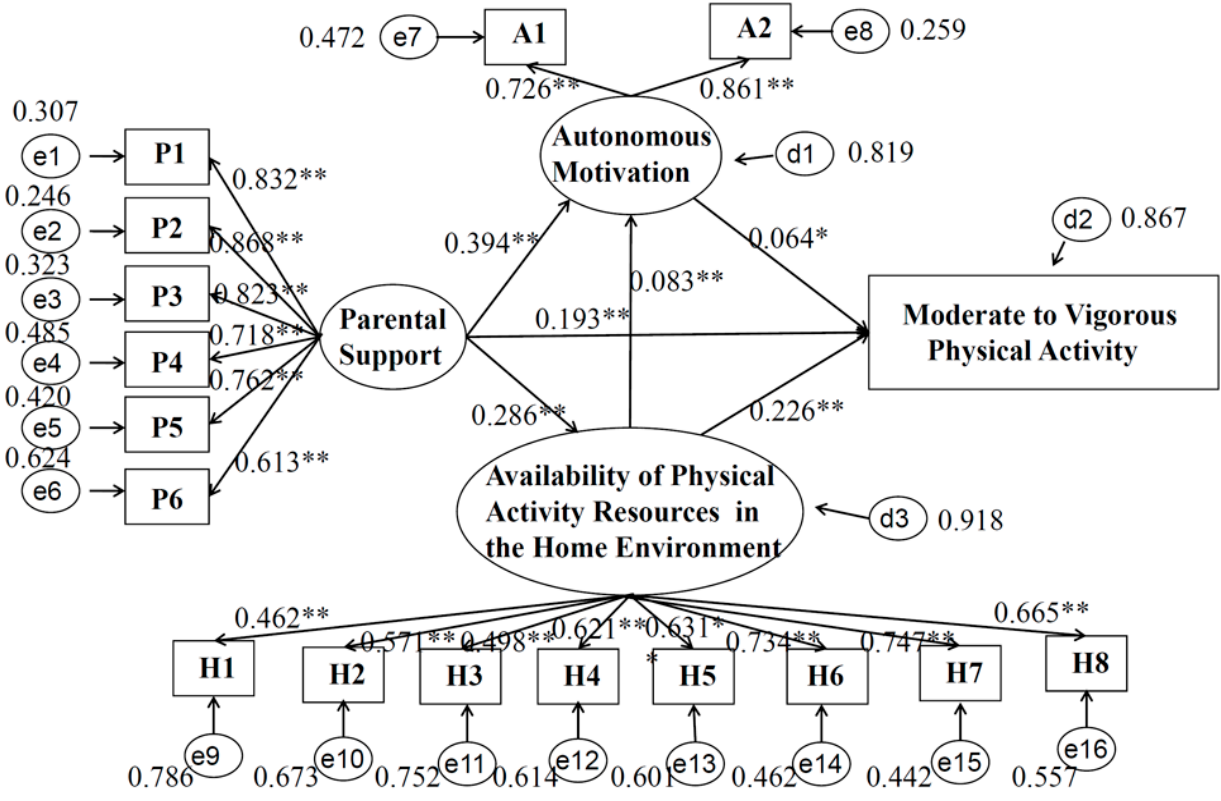
Figure 2. Model of moderate to vigorous physical activity for boys. Note: ** p < 0.001, * p <